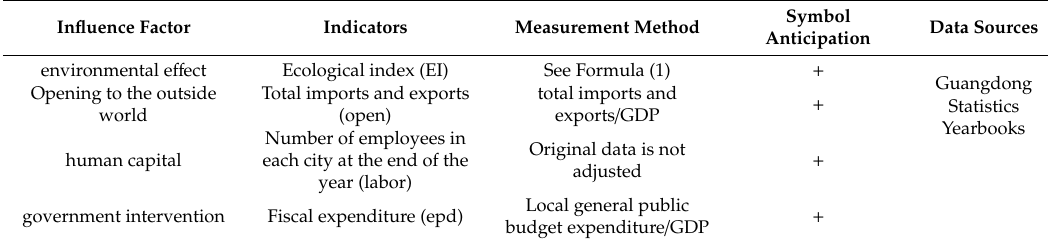
Table 2. Indicators of Influencing Factors of ESTFP.